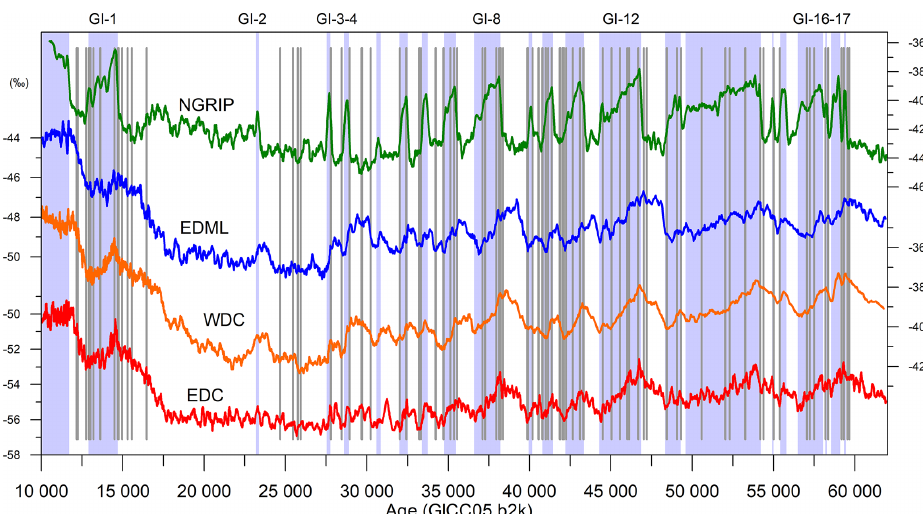
Figure 1. Greenland (NGRIP) and Antarctic (EDML, WDC, and EDC) climate records ( δ 18 O) throughout the 10–60ka time period based on volcanic matching. Ages are on the GICC05 timescale relative to the year 2000CE (“b2k”). Grey vertical lines show the position of bipolar volcanic match points identified in this study (Table S2) together with five match points based on cosmogenic isotopes around 41ka (Raisbeck et al., 2017). Blue-shaded intervals indicate the Greenland Interstadial (GI) periods according to the definition of Rasmussen et al. (2014). The bipolar synchronization for the 16.5–24.5ka interval is tentative as there are no bipolar match points in that